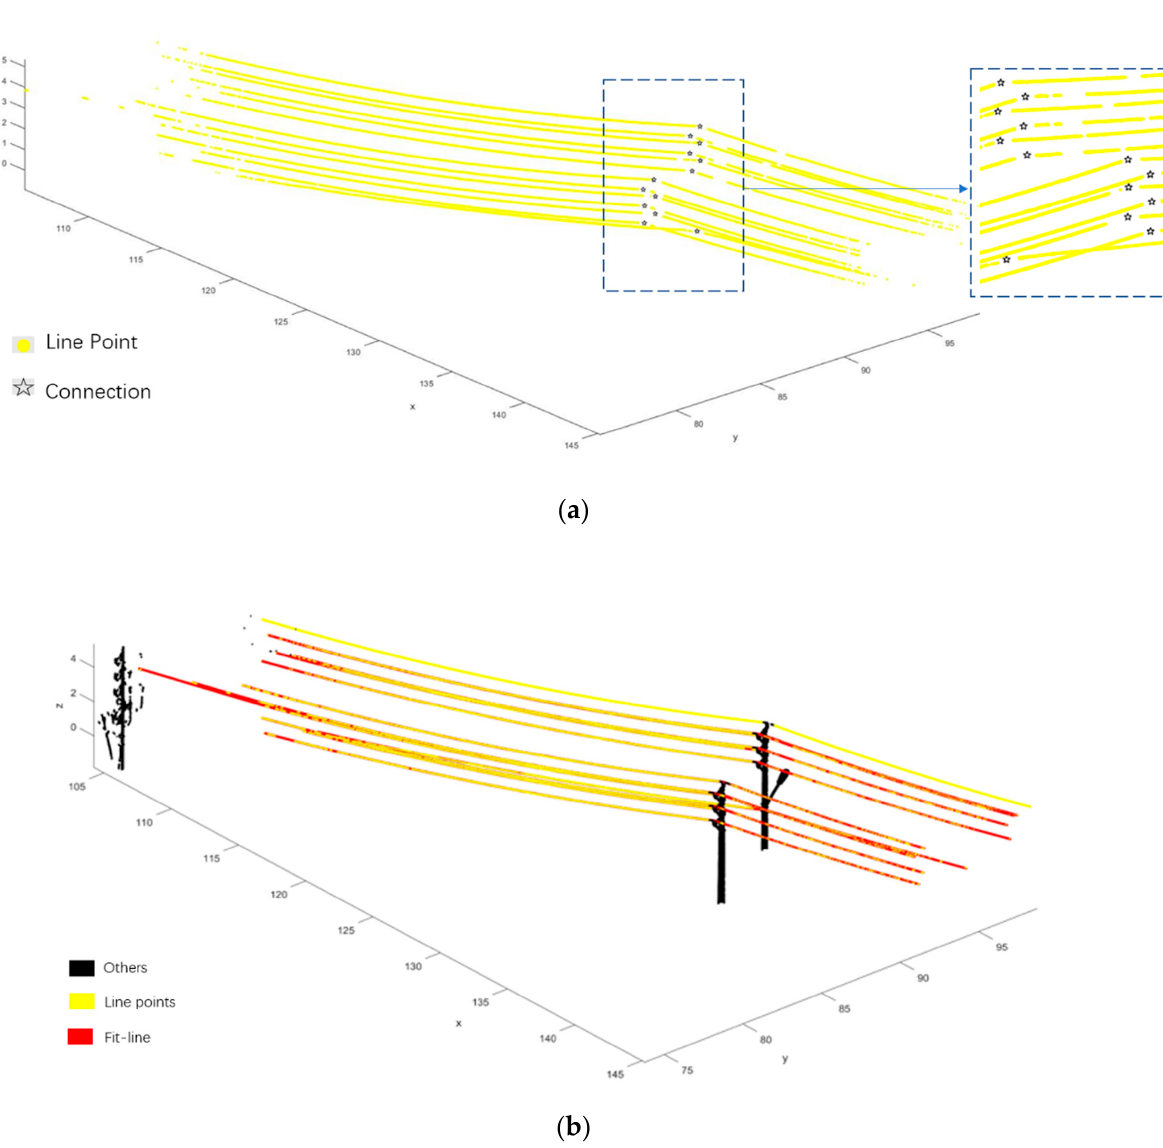
Figure 15. Connection finding and powerline reconstruction. ( a ) Pylon–powerline connections finding. Connections are shown as black stars and powerline points are colored in yellow. ( b ) Reconstruction results. Outliers are colored in black and powerline points are in colored in yellow. Fitted results are presented by red lines, most of which are obscured by line points.